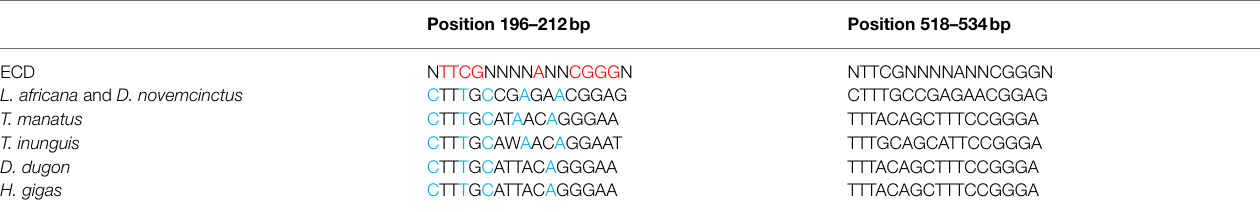
Conserved nucleotides in the evolutionarily conserved domain (ECD) are shown in red/highlighted, and conserved nucleotides compared with L. africana and D. novemcinctus motif (Alkan et al., 2007) other than the ECD domain are shown in